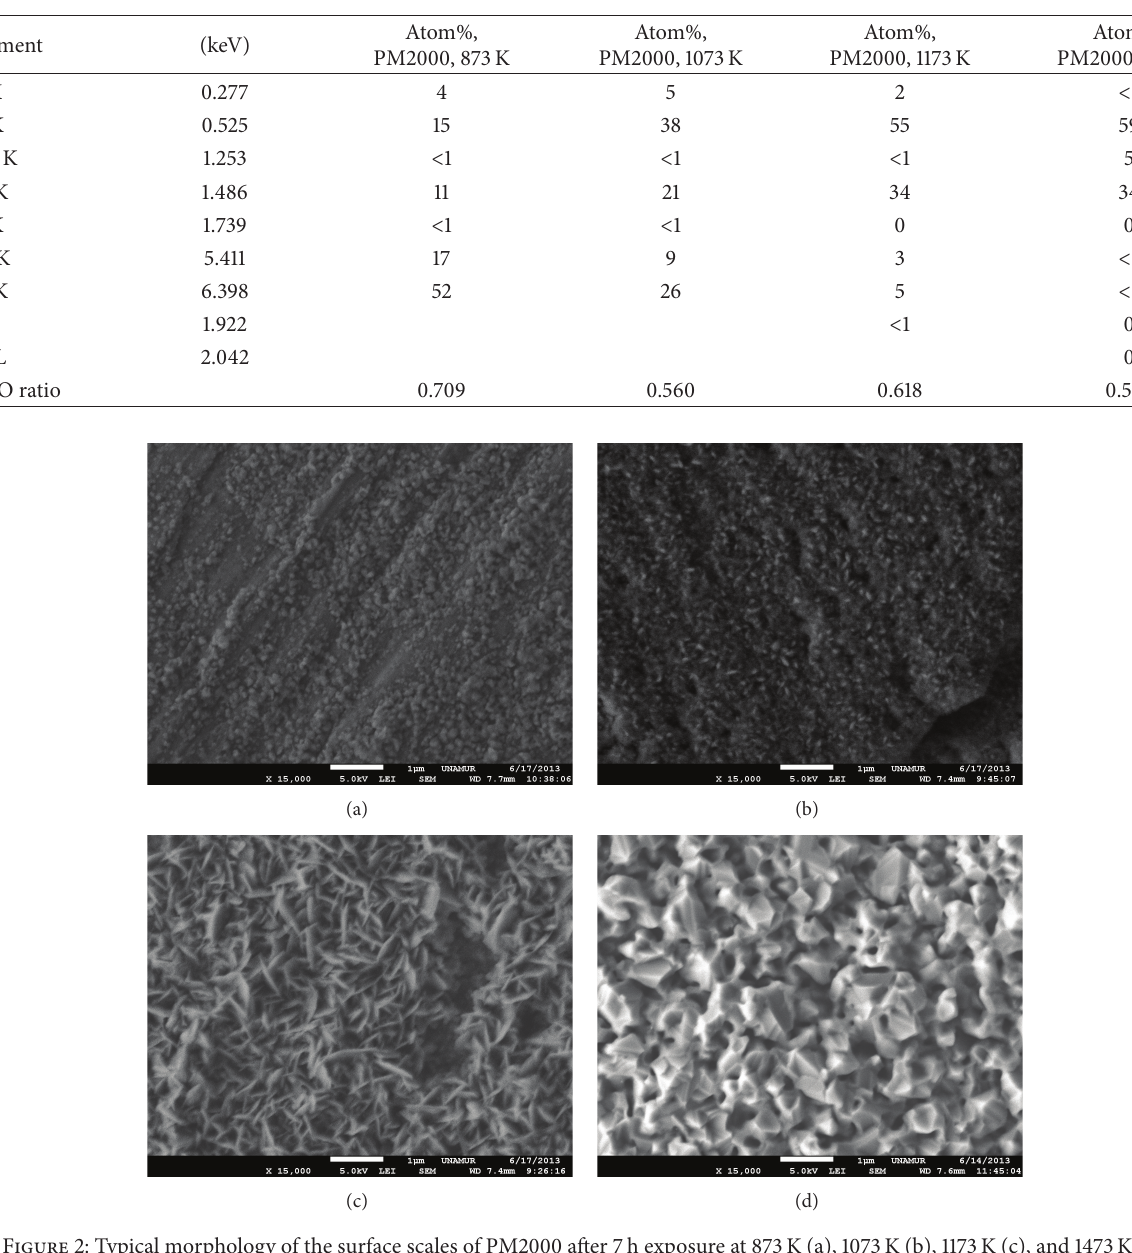
Table 1: Composition and stoichiometry of the thin films obtained by statistical analysis of EDX spectrum.